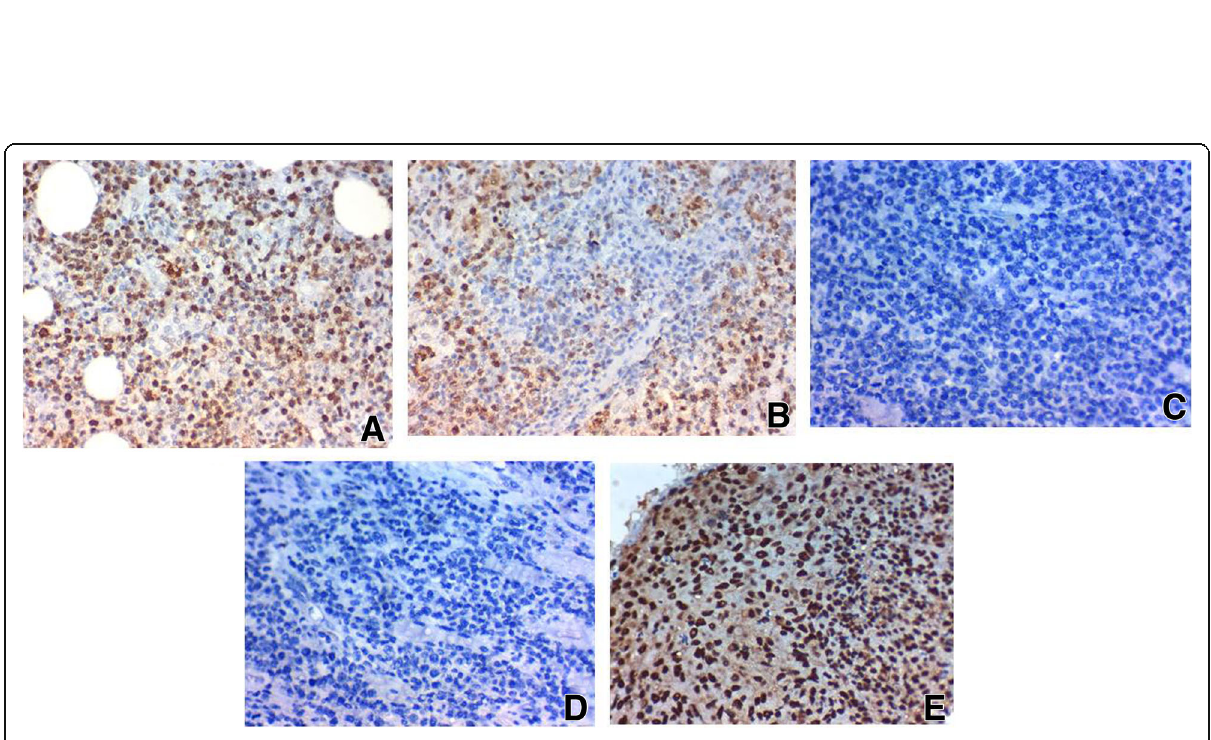
Fig. 1 Immunohistochemical expression of Programmed cell death-ligand 1 (PD-L1) ( a ) high cytoplasmic and membranous PD-L1 expression in DLBCL; stage IV × 400 ( b ) high cytoplasmic and membranous PD-L1 expression in DLBCL; stage III × 400 ( c ) low cytoplasmic and membranous PD-L1 expression in DLBCL; stage II × 400 ( d ) negative cytoplasmic and membranous PD-L1 expression in DLBCL; stage I × 400. ( e ) Positive cytoplasmic and membranous PD-L1 expression in sections from adenocarcinoma of the colon as appositive control of the marker × 400. ( f ) Negative control by replacement of the primary anti-PD-L1 antibody by phosphate buffered saline × 400